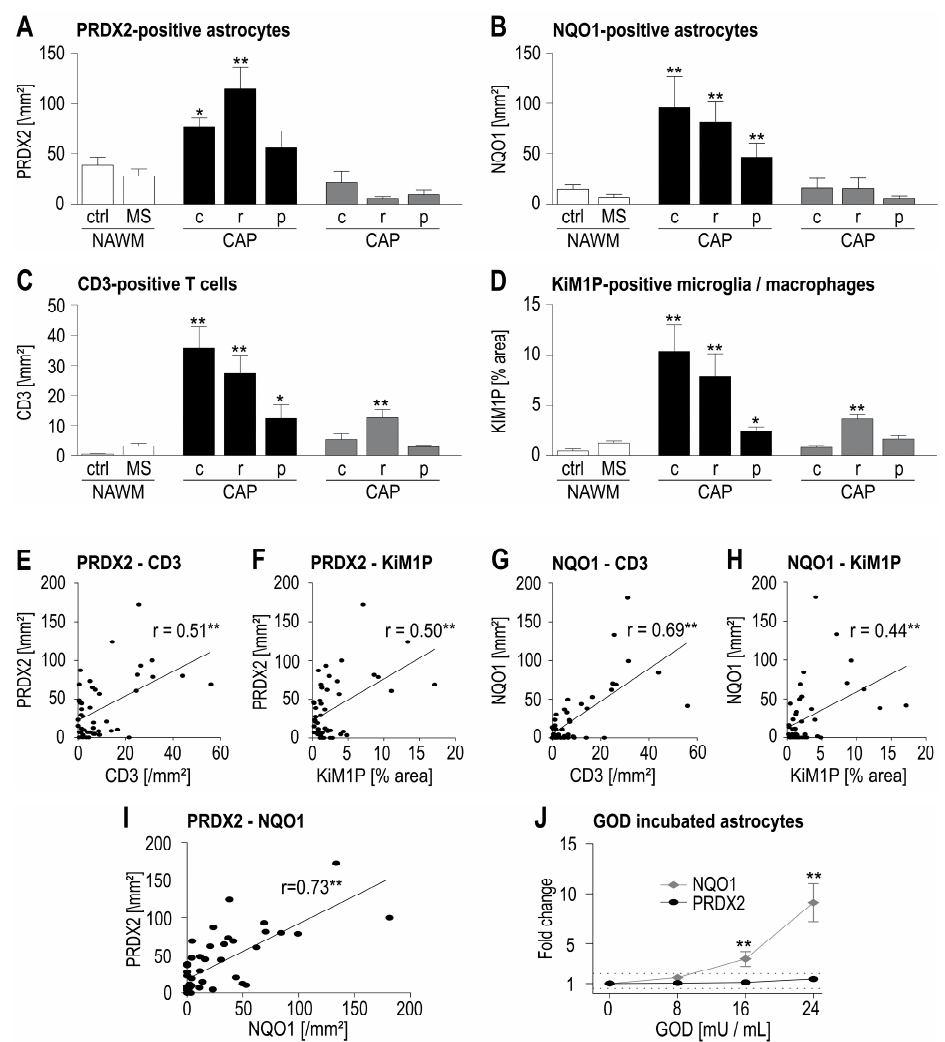
Figure 2. PRDX2 and NQO1 expression ( A , B ) in relation to inflammation ( C – H ) and oxidative stress ( I , J ). PRDX2-/NQO1-expressing astrocytes, T cells (CD3) and activation of microglia/macrophages (KiM1P) were evaluated in the normal appearing white matter (NAWM) of controls (ctrl) and MS patients as well as in four chronic active MS plaques (CAP) and five chronic inactive MS plaques (CIP). All measurements were performed separately in the center of the lesions (c), the rim of the lesions (r) and the peri-plaque white matter (p). Within the lesions, a comparable distribution pattern of CD3, KiM1P as well as astrocytic PRDX2 and NQO1 expression was found ( A – D ). The highest expression of these markers was observed in the center and at the rim of CAP, and was significantly higher than in MS NAWM or in white matter of controls (Mann–Whitney U -test). The number of PRDX2- and NQO1-expressing astrocytes showed a significant positive correlation (Pearson r) with the number of T cells and the activation of microglia/macrophages (PRDX2 in ( E , F ), NQO1 in ( G , H )). Moreover, a strong positive correlation between PRDX2 and NQO1 expression was found ( I ). In vitro experiments showed that incubation of primary murine astrocytes with glucose oxidase (GOD) for 24 h increased NQO1 but not PRDX2 in the cells as measured by quantitative PCR (( J ), ANOVA, error bars represent SD). ** p < 0.01, * p < 0.05.